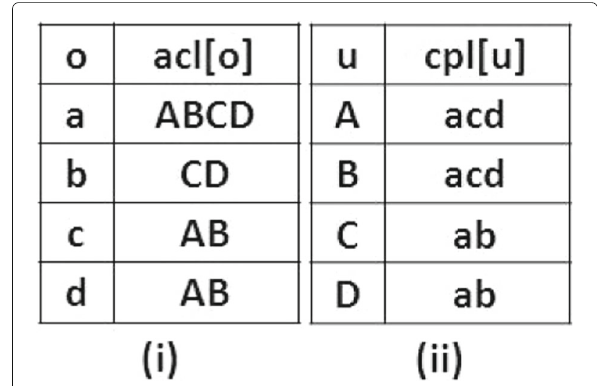
Fig. 1 An example access control matrix as ( i ) ACLs ( ii ) CPLs